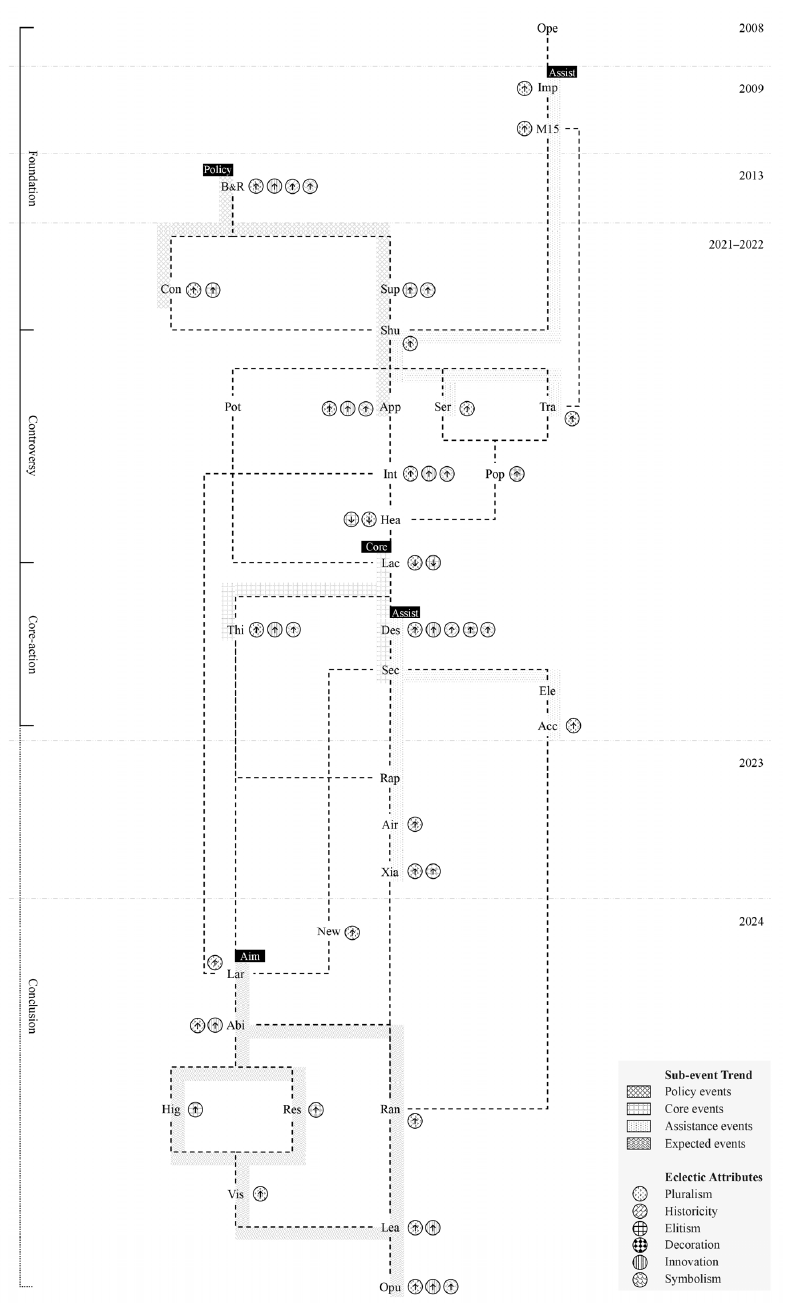
Figure 4. The event structure network model of narrative 2.